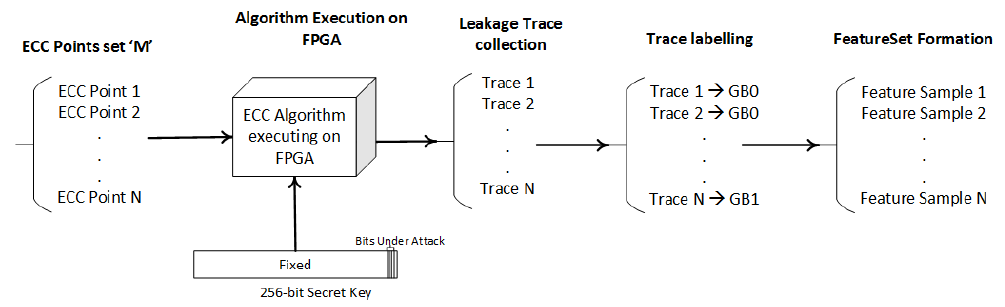
Figure 5. Dataset